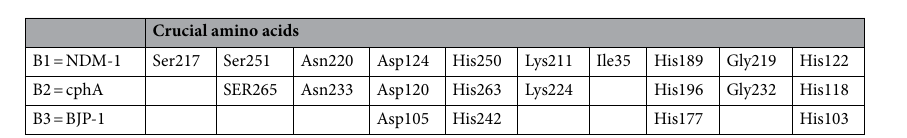
Table 6. Crucial amino acids and their analogous amino acids in different types of